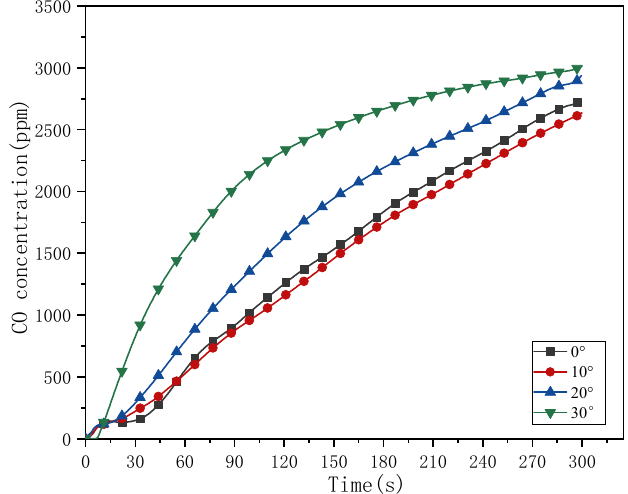
Figure 17. The CO concentration in transition room at different jet angles. When the air curtain jet angle is 0°, the air curtain airflow flows vertically to the chamber door ground floor, which results in a lower concentration than when the air curtain jet angle is 10°. The airflow from the air curtain will tilt toward the transition room because of the buoyancy created by hot pressing, partially reducing the air curtain barrier effect. As a result of heat pressing, the air curtain airflow blows vertically to the ground when the jet angle it has towards high concentration CO is 10°. The air curtain has an excellent blocking effect, and the jet angle is 10°. Figure 18 shows the velocity cloud diagram of airflow in the air curtain at a jet angle of 10°. The air curtain is more effective at obstructing CO because, as shown in the picture, it blows to the ground vertically while being affected by the thermal pressure of the environment outside. Figure 19 shows the CO concentration cloud diagram at varying moments in the transition room now that the air curtain jet angle is 10°. The cloud diagram shows that installing an air curtain to block CO has a significant impact as compared to not performing it. The length to be sealed also increases as the angle of the curtain jet increases since it increases the distance from the nozzle to the refuge ground. To create a complete air curtain, it is necessary to raise the jet velocity of the air curtain and the overall kinetic energy of the airflow. The CO barrier effect decreases if the jet velocity stays constant and the air curtain jet angle keeps rising.